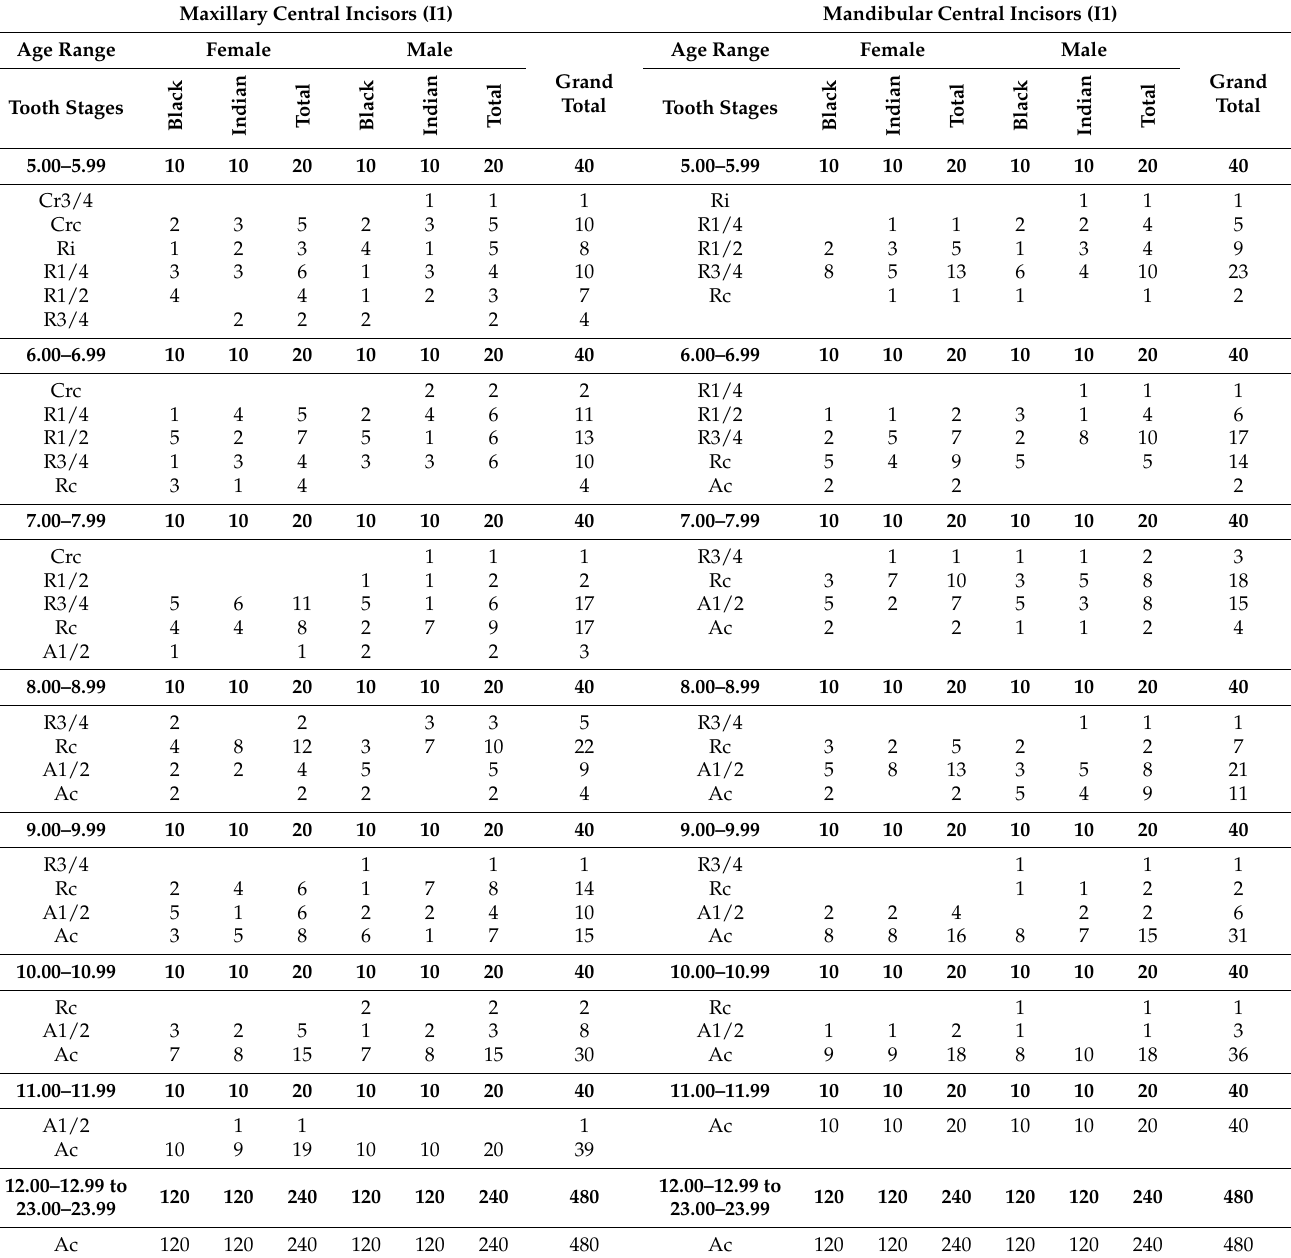
Table A1. Frequencies of the tooth development stages of the central incisors for the SA Black and Indian population